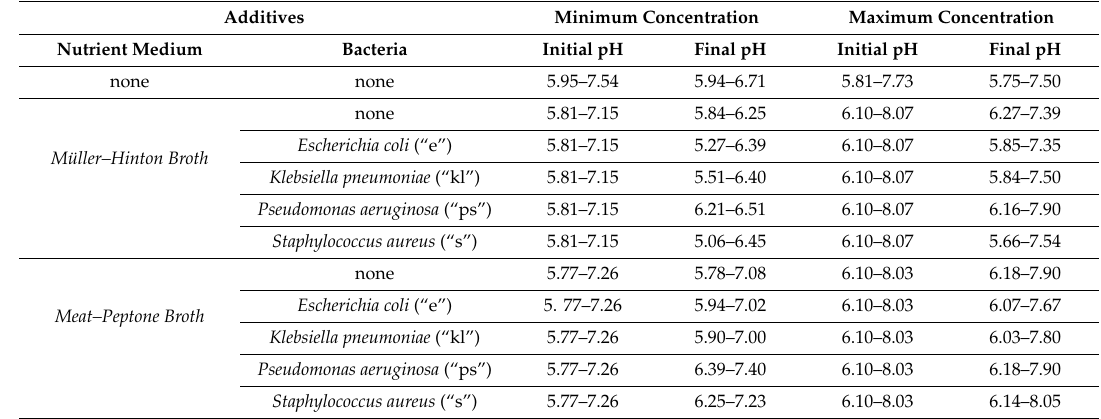
Table 2. The change in pH of the solutions during the experiment in nutrient media with the addition of